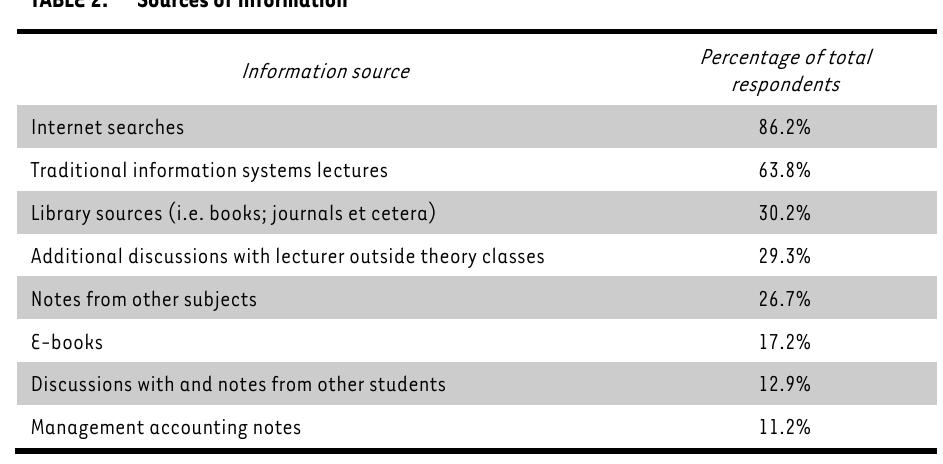
Percentage of total